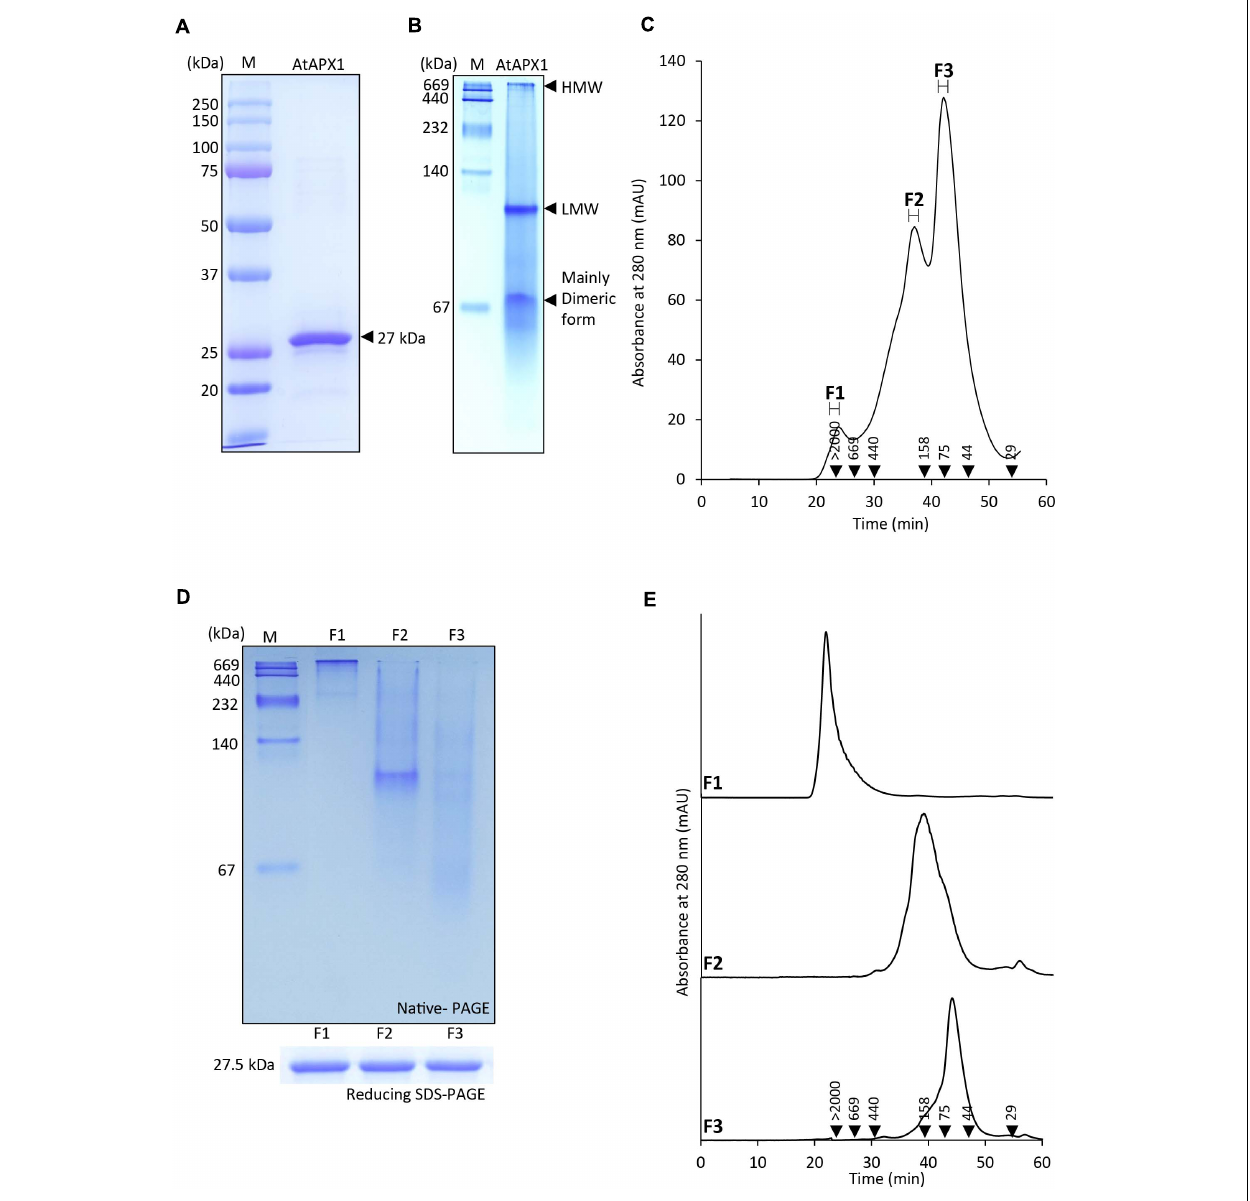
FIGURE 1 | Protein structure of AtAPX1 protein analyzed by (A) reducing SDS-PAGE, (B) native-PAGE, and (C,E) size exclusion chromatography (SEC). The values in the chromatogram represent the molecular weights of the standard proteins: blue dextran ( > 2,000 kDa), thyroglobulin (669 kDa), ferritin (440 kDa), aldolase (158 kDa), conalbumin (75 kDa), ovalbumin (44 kDa), and carbonic anhydrase (29 kDa). The three peaks (F1-F3) of separated proteins were collected and used for further analysis. (D) The fractions were separated by 10% native-PAGE and 12% reducing SDS-PAGE. (E) Each of the fractions was rechromatographed by SEC to confirm their